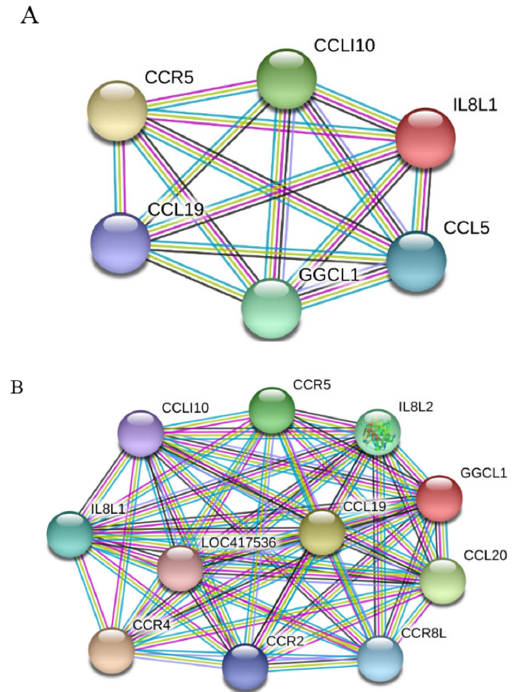
Figure 4. Analysis of DEG expression of splenic lymphocytes in CVI988, vvRB1B, and mock groups. The relative quantity of IL-6, IL-1β, IL-10, IFN-γ, STAT1, IRF1, IL8L1, GGCL1(CCL4), CCL5, CCL19, and CCL26 (CCLI10) gene expression of splenic lymphocytes in CVI988, vvRB1B, and control groups. “NS” indicates no significant difference ( p > 0.05). “*”, “**” and “***” indicate statistically significant differences with values of p < 0.05, p < 0.01, and p < 0.001, respectively.